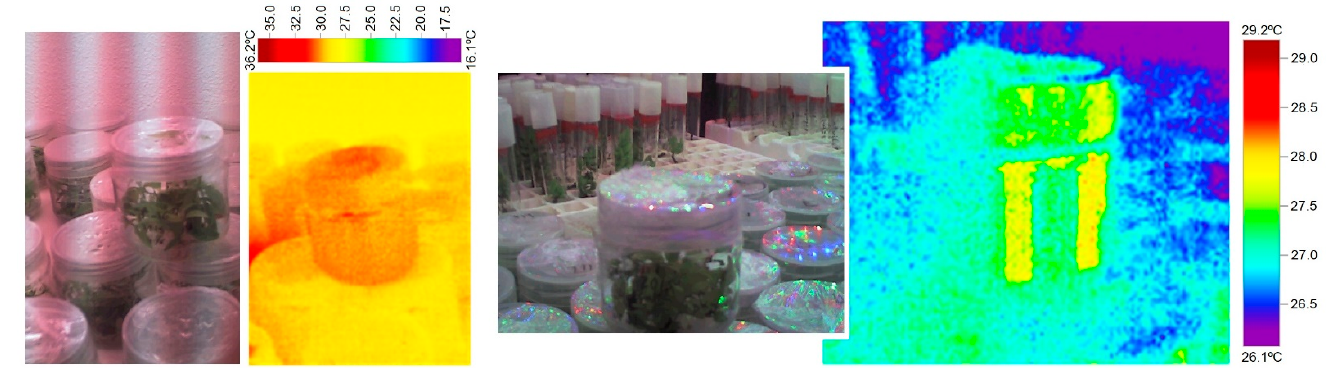
Figure 7. Thermographic images of the temperature in the vessels under ( a ) Grolux fluorescent lighting and ( b ) LED lighting. (Thermographic camera model 875. Manufacturer Testo).